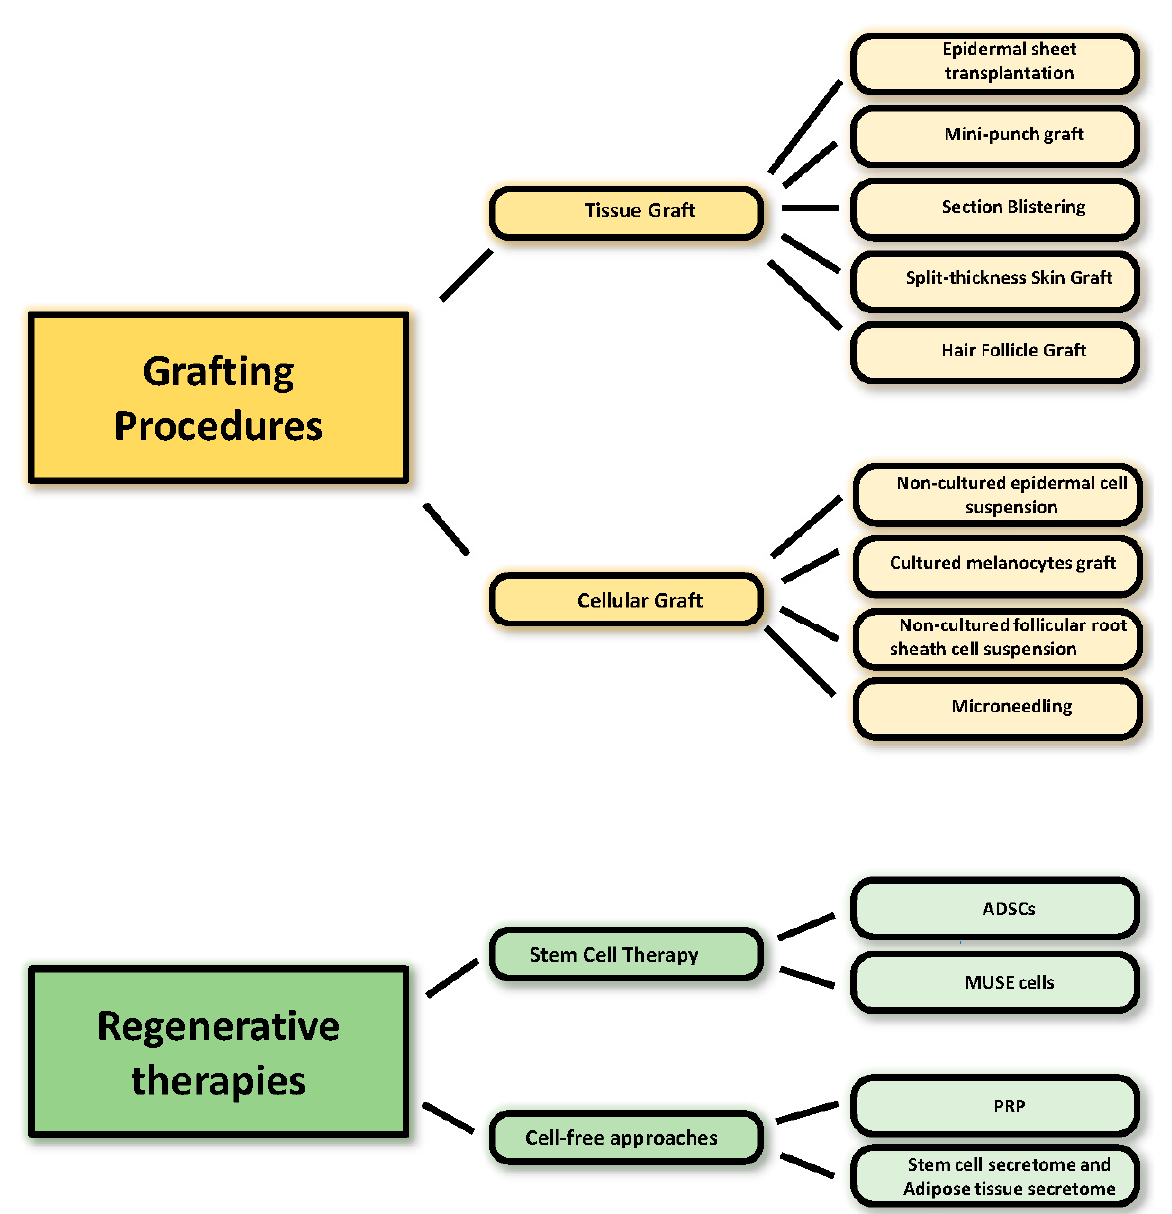
Figure 2. Schematic summary of current procedures in vitiligo